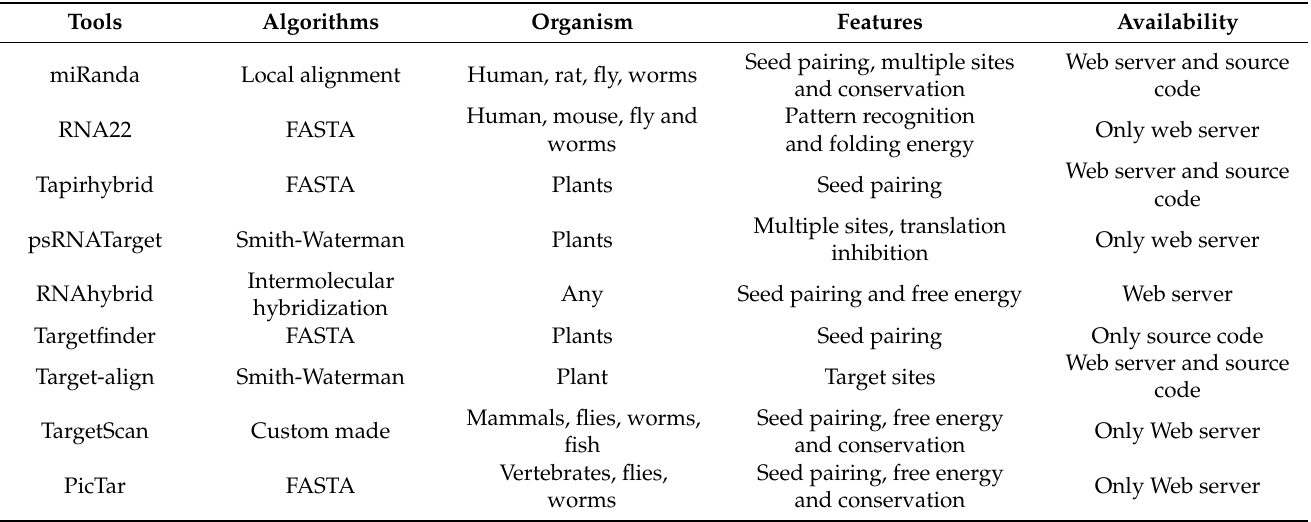
Table 1. Summary of algorithms considered for miRNA-mRNA target predictions in this